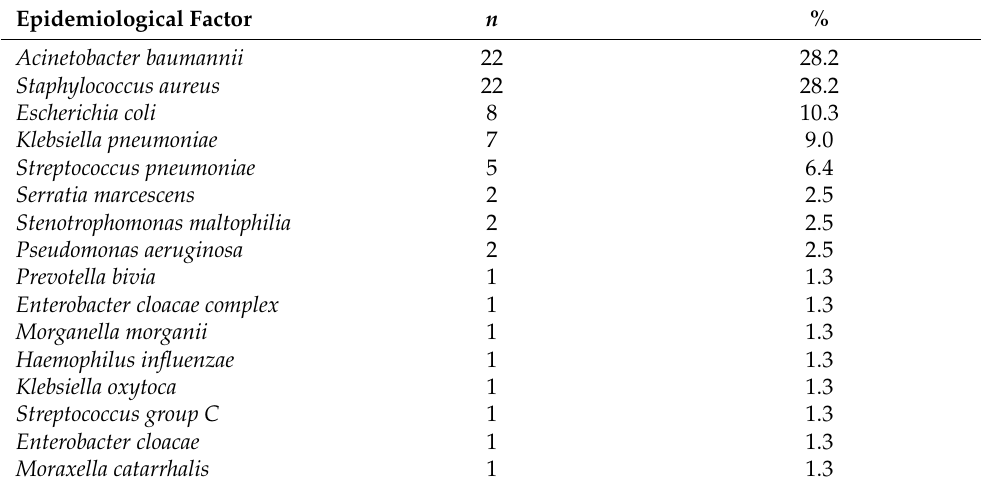
Table 3. Epidemiological factors of pneumonia in the studied group based on the inoculation from the respiratory tract secretion—bacteria.